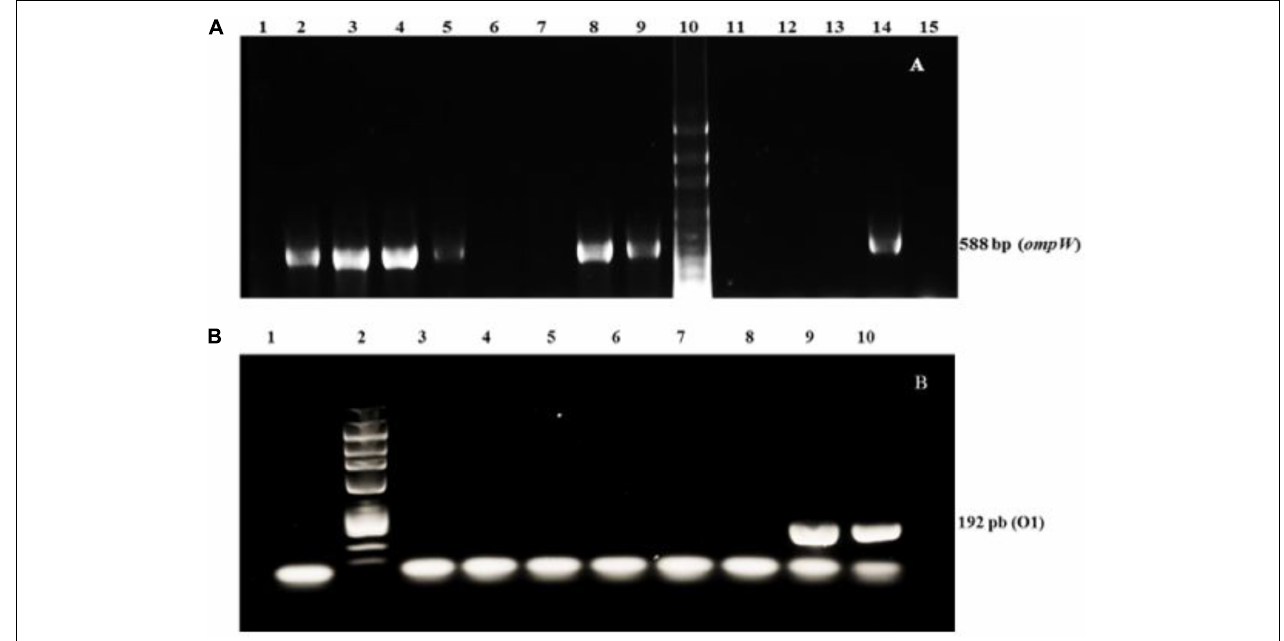
FIGURE 2 | Electrophoretic profiles. (A) ompW PCR. Lane 1: blank (no DNA); Lanes 2–4, 8, and 9: positive samples; Lanes 5, 6, 7, 11–13: negative samples; Lane 10: 100 bp DNA Ladder; Lane 14: positive control ( V. cholera non-O1/non-O139, CAIM 1407). Lane 15: negative control ( V. vulnificus , CAIM 610). (B) O1 ( ctxA ) PCR. Lane 1: blank (no DNA); Lane 2: 100 bp DNA Ladder; Lanes 3–7: negative samples; Lane 8: negative control ( V. vulnificus , CAIM 610); Lanes 9 and 10: positive controls ( V. cholera O1, CAIM 1408). Numbers on the right indicate the size of the amplification products corresponding to the 588 and 192 bp internal fragments of the ompW and O1 genes,